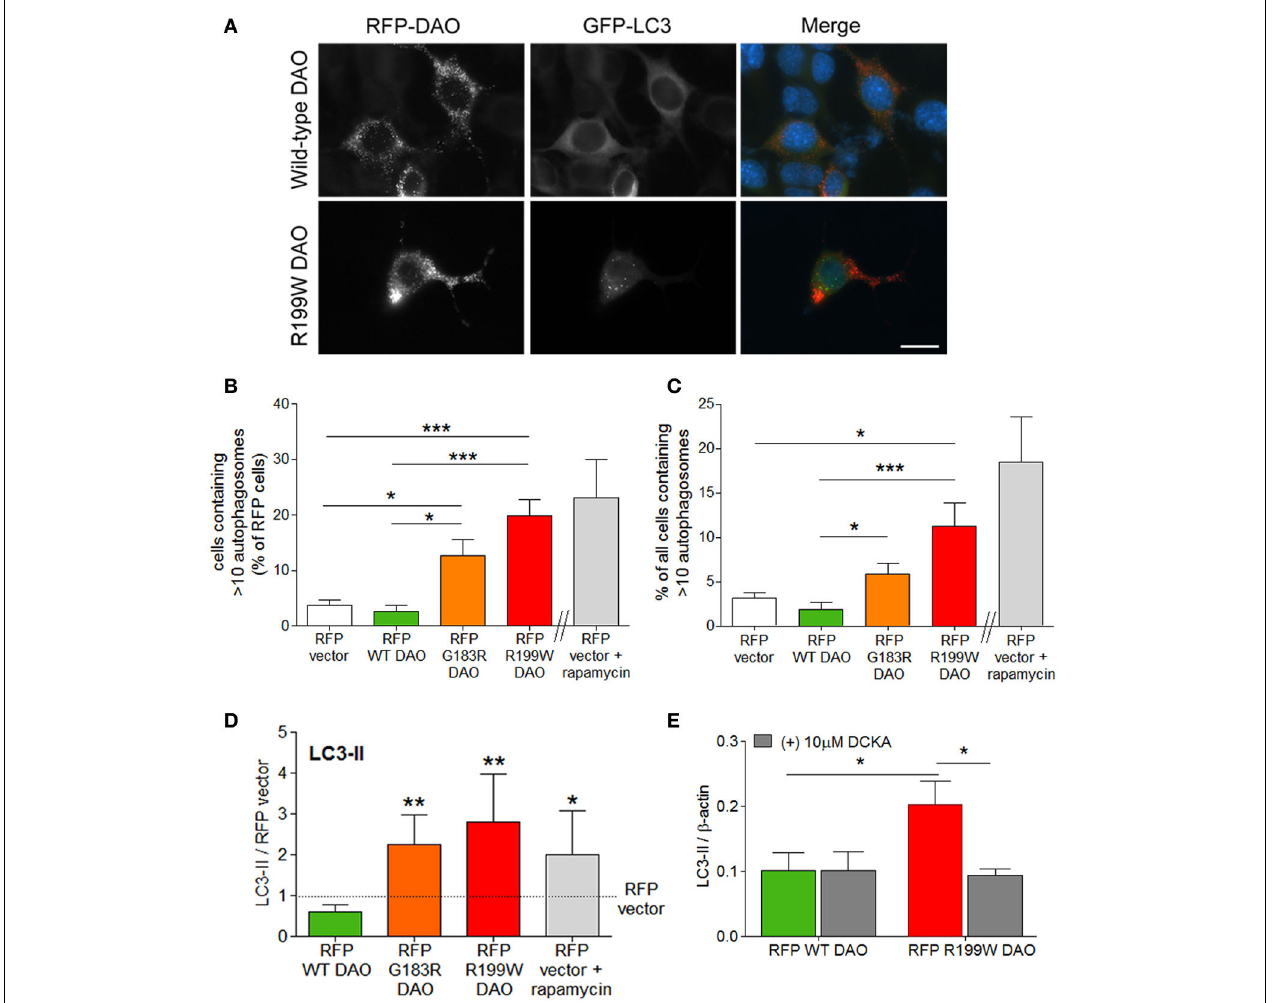
FIGURE 2 | R199W DAO promotes autophagy in neuronal cells. NSC-34 cells were co-transfected with RFP-tagged DAO and GFP-tagged LC3. (A) Representative immunofluorescence images show RFP-DAO (red) GFP-LC3 (green) and DAPI nuclear stain (blue). Scale bar: 20um. Number of (B) vector or DAO transfected cells or (C) cells containing > 10 GFP-LC3 puncta or autophagosomes. Rapamycin induced